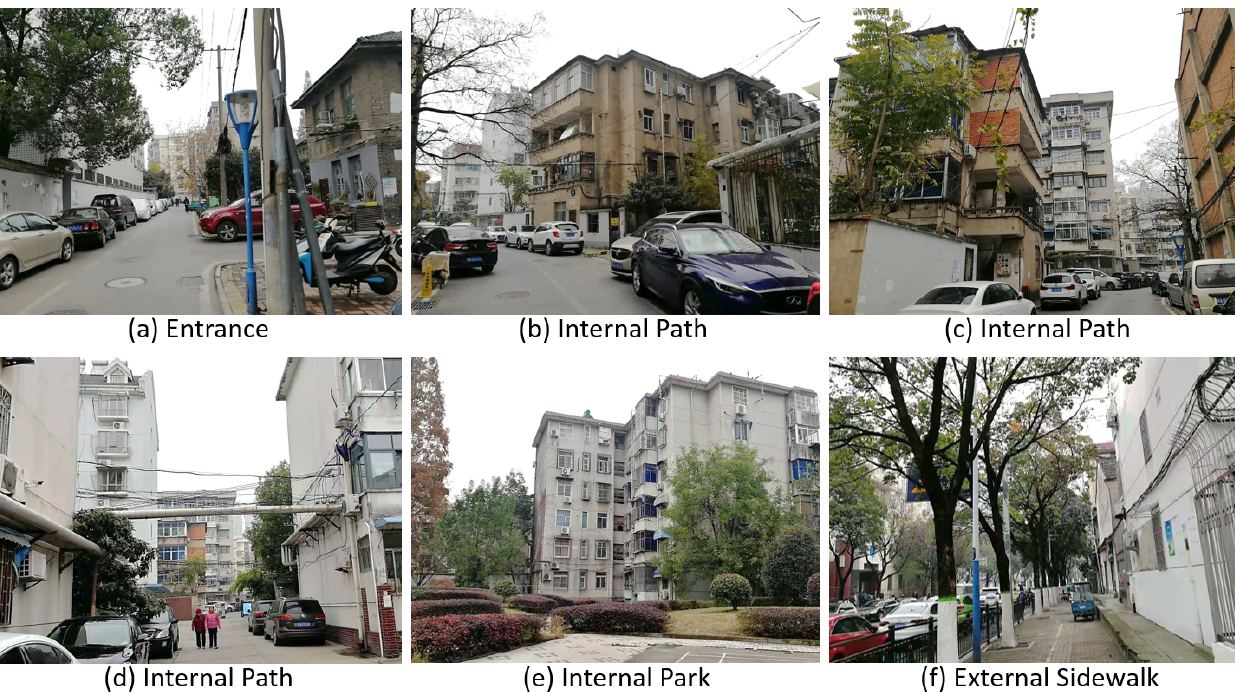
Figure 4. Photos of the AMS compound.